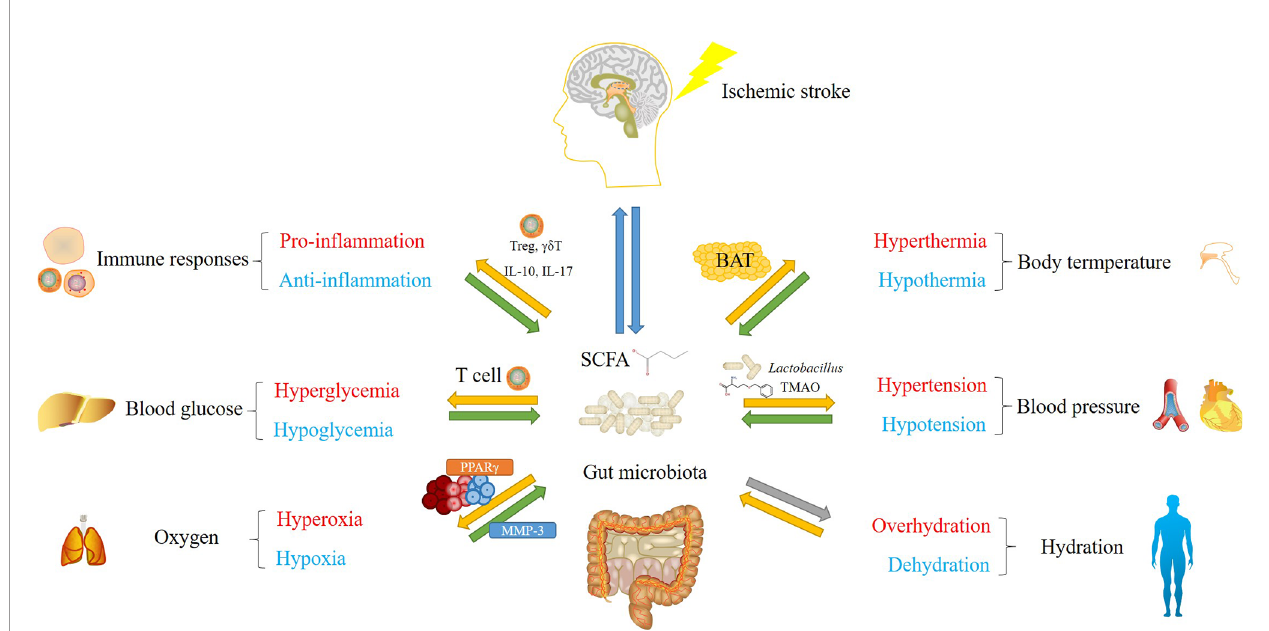
FIGURE 1 | An overview of major concerns in post-stroke management in fl uenced by gut microbiota. Green arrows represent solid functions, yellow arrows represent opposite functions or functions with relatively weaker evidence, gray arrows show effects without solid evidence. Gut microbiota and their metabolic products, mainly short-chain fatty acid (SCFA), regulate immune responses, body temperature, blood glucose, blood pressure and oxygen level after stroke. Their populations and diversities are also altered by these factors. Gut microbiota-mediated modulation involve mechanisms including the regulation of T cell (immune responses and blood glucose), the regulation of UCP1 gene expression in brown adipose tissue (BAT) (body temperature), SCFA and trimethylamine N-oxide (TMAO)-mediated opposite effects on blood pressure, and PPAR g -mediated oxygen exclusion. Although gut microbiota populations are considered to be in fl uenced by altered hydration status, whether they conversely regulate hydration remains